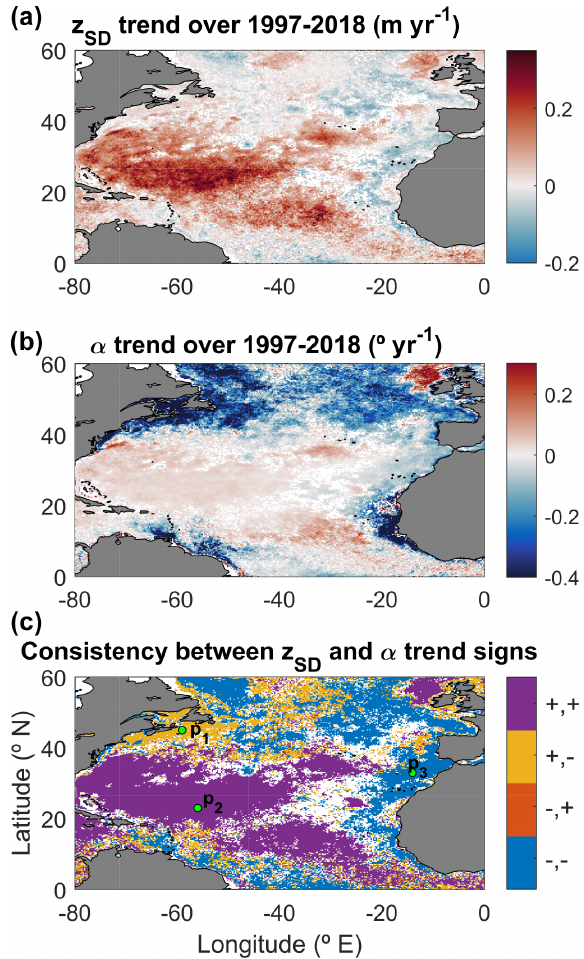
Figure 4. Global maps of the Forel–Ule (FU) index in the period 1997–2018. (a) Series mean. (b) Standard deviation. (c) Coefficient of variation. Figure 5. (a) Linear slope of Secchi disk depth ( z SD ) trend at pixel scale for the North Atlantic. (b) Same as before but for the hue angle ( α ). (c) Signs of both linear